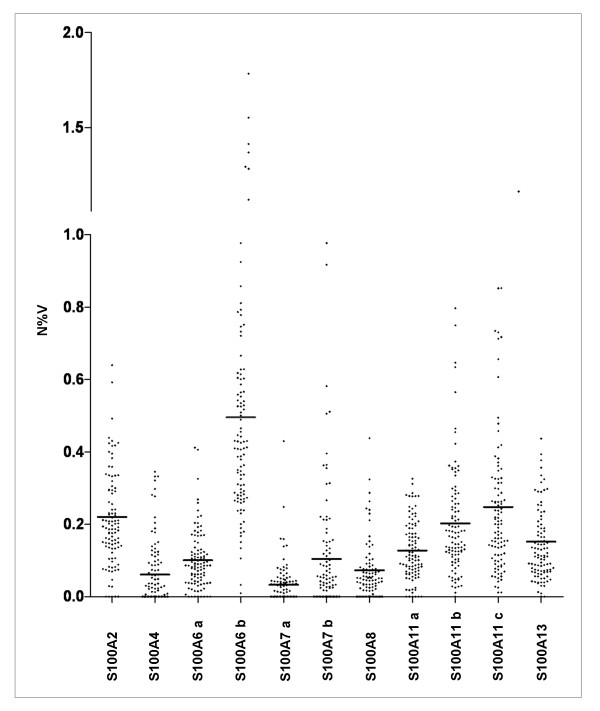
Diagram of the relative intensities of the eleven S100 protein forms among the 100 patients. In abscissa are indicated the protein names and in the ordinate the density values. Bars indicate the mean of each protein expression level among patients.